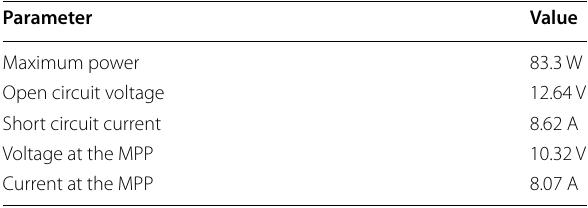
Table 2 PV module specifications